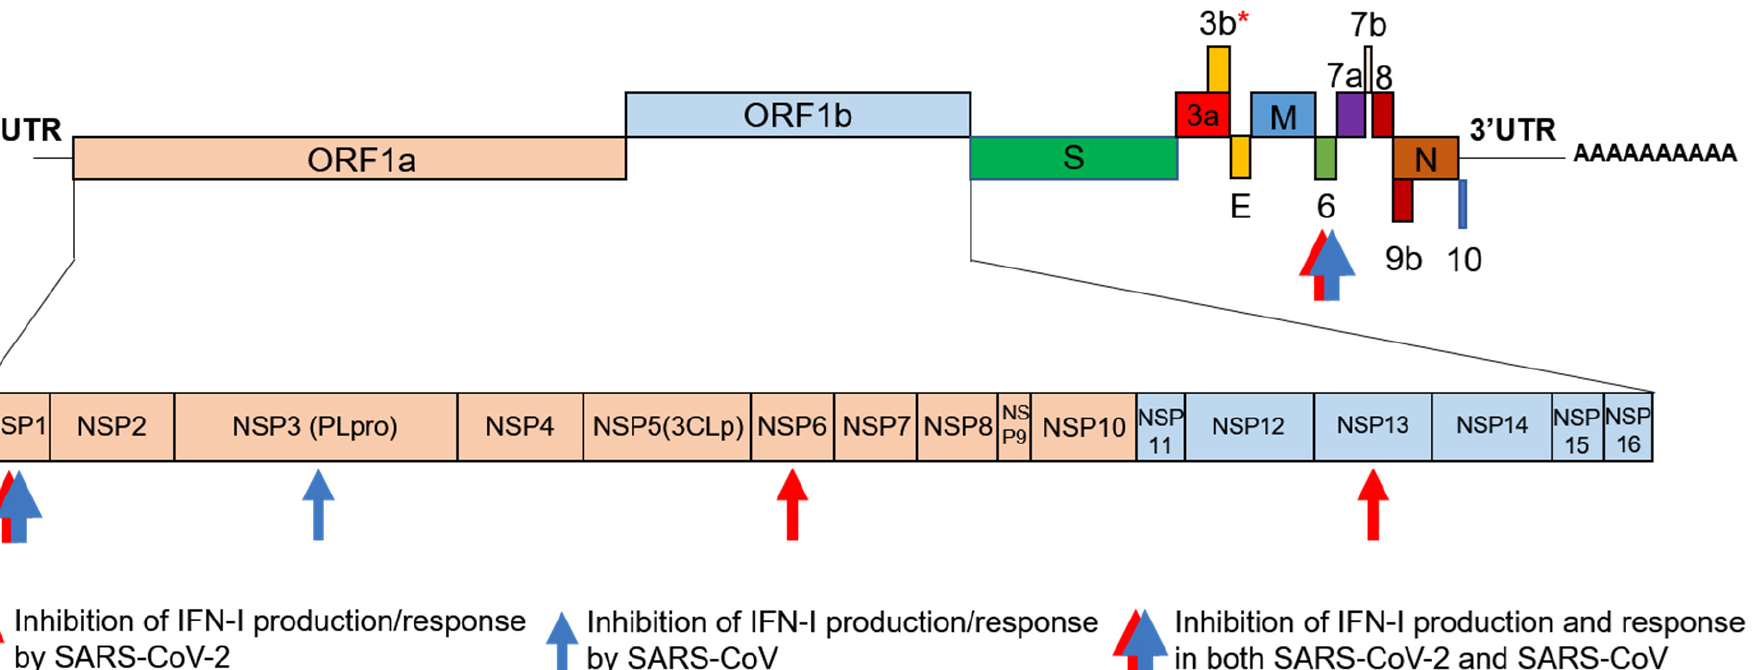
Figure 1. Schematic representation of SARS-CoV-2 genomic organization and gene products. Red arrows, pointed at genes, represent the inhibition of IFN-I production and response determined by the corresponding SARS-CoV-2 gene product. Blue arrows, pointed at genes, represent the inhibition of IFN-I production and response determined by the corresponding SARS-CoV gene product. Combined red and blue arrows, pointed at ORF-6 and NSP1, represent the inhibition of the IFN-I production and the response to IFN-I, determined by the corresponding SARS-CoV and SARS-CoV-2 gene products. * = increased anti-IFN activity in its naturally occurring elongation